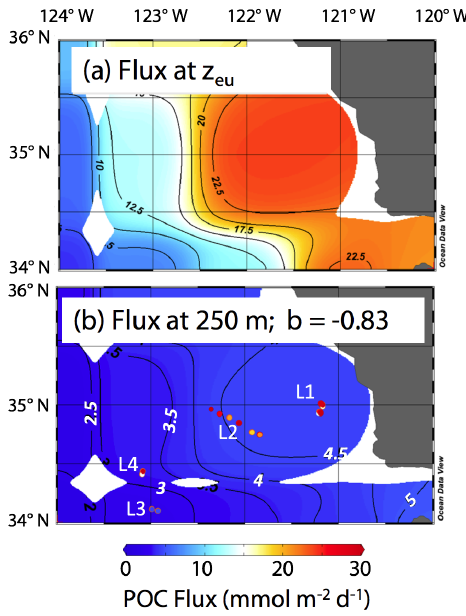
Figure 17. (a) Euphotic zone carbon export for climatological aver- aged June from Siegel et al. (2014). (b) Fluxes calculated for 250m using Eq. (1) and the b value from VERTEX I ( − 0 . 83; Martin et al., 1987). The euphotic zone depth ( z eu ) used for the calculation was June climatology from NASA VIIRS. Also shown using the same colour scale are POC ATN flux values near 250m. The CFE fluxes are far higher than model predictions at depth at all locations except